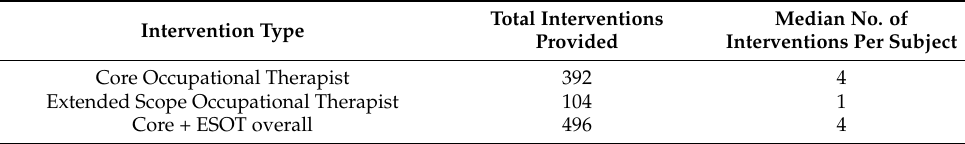
Table 5. Summary of interventions provided by